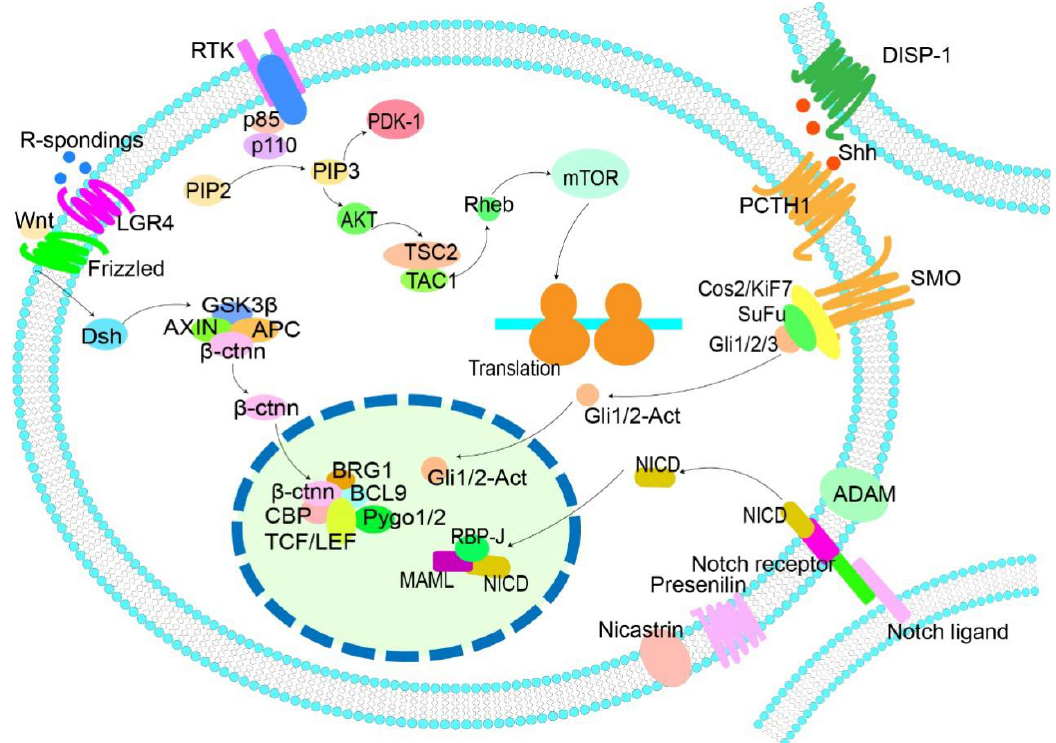
Figure 1. Known pathways related to stemness in MM. Dsh, disheveled protein; APC, adenomatous polyposis coli; β -ctnn, β -catenin; PI3K, phosphatidylinositol-3-kinase; DISP1, dispatched 1; SHH, sonic hedgehog; PTCH1, patched1; ADAM, a disintegrin and metalloprotease; NICD, Notch1 intracellular domain; RBP-Jk, recombination signal-binding protein- Jkappa; MAML, mastermind-like family members. This image describes the common pathways related to stemness and corresponding targets in MM cells. The Wnt, Notch, and hedgehog pathways can regulate MM cells at the transcription level, and PI3K at the translation level, and all of them are involved in the regulation of cell growth, survival, and drug resistance. In the Wnt pathway, GSK3 β protein expression was upregulated, and Wnt activation was inhibited on pathway activation. In Hedgehog pathway, Shh and Gli1 can regulate bcl-2. In the Notch pathway, sahn1 can bind to the intracellular domain ICN of Notch and affect the recruitment of MMAL. GSI (an enzyme inhibitor) can act on γ -secretase and cause MM cell toxicity. In the PI3K/Akt/mTOR pathway, buparlisib can act on P110, while nvp-bez235 (imidazolo-